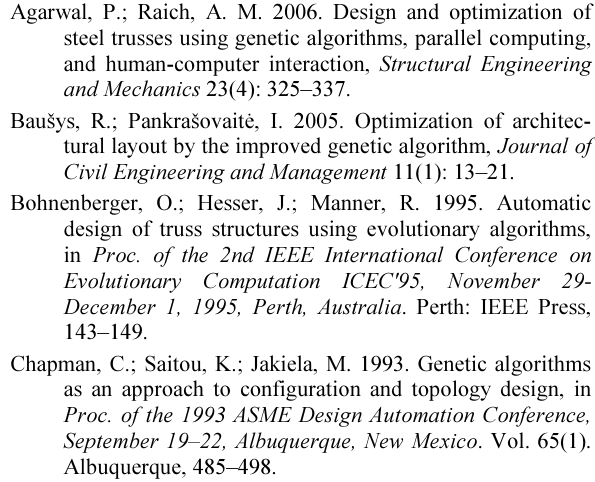
Fig. 16. Global solution obtained in full search